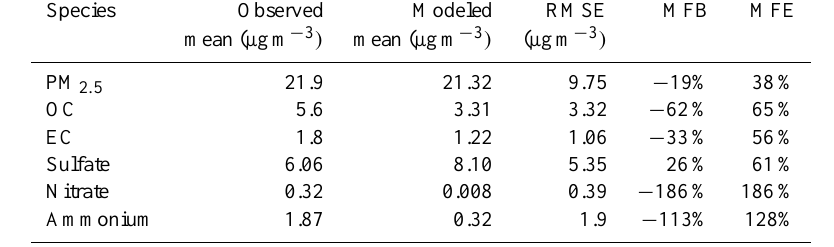
Table 6. Statistical performance evaluation for PM 2 . 5 , OC, EC and particulate sulfate, nitrate and ammonium at USJ for the simulation A1. Species